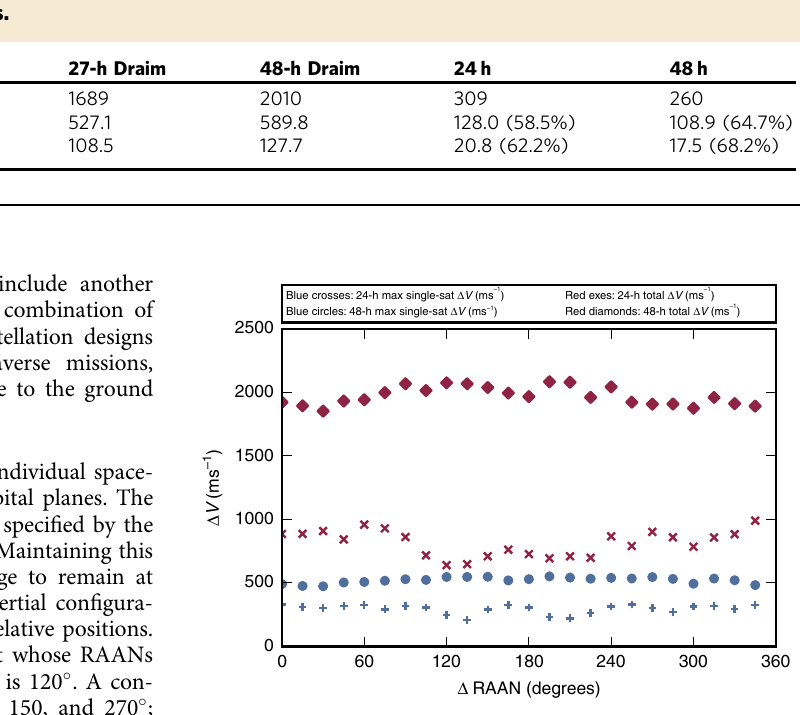
Fig. 3 Station-keeping Δ V requirement. Total constellation (red) and maximum single satellite (blue) reported as a function of constellation and shift in RAAN applied uniformly to all satellites. The relatively fl at curves indicate that constellations are not constrained to the reported gap locations, and can be adjusted with a limited impact to lifetime propellant